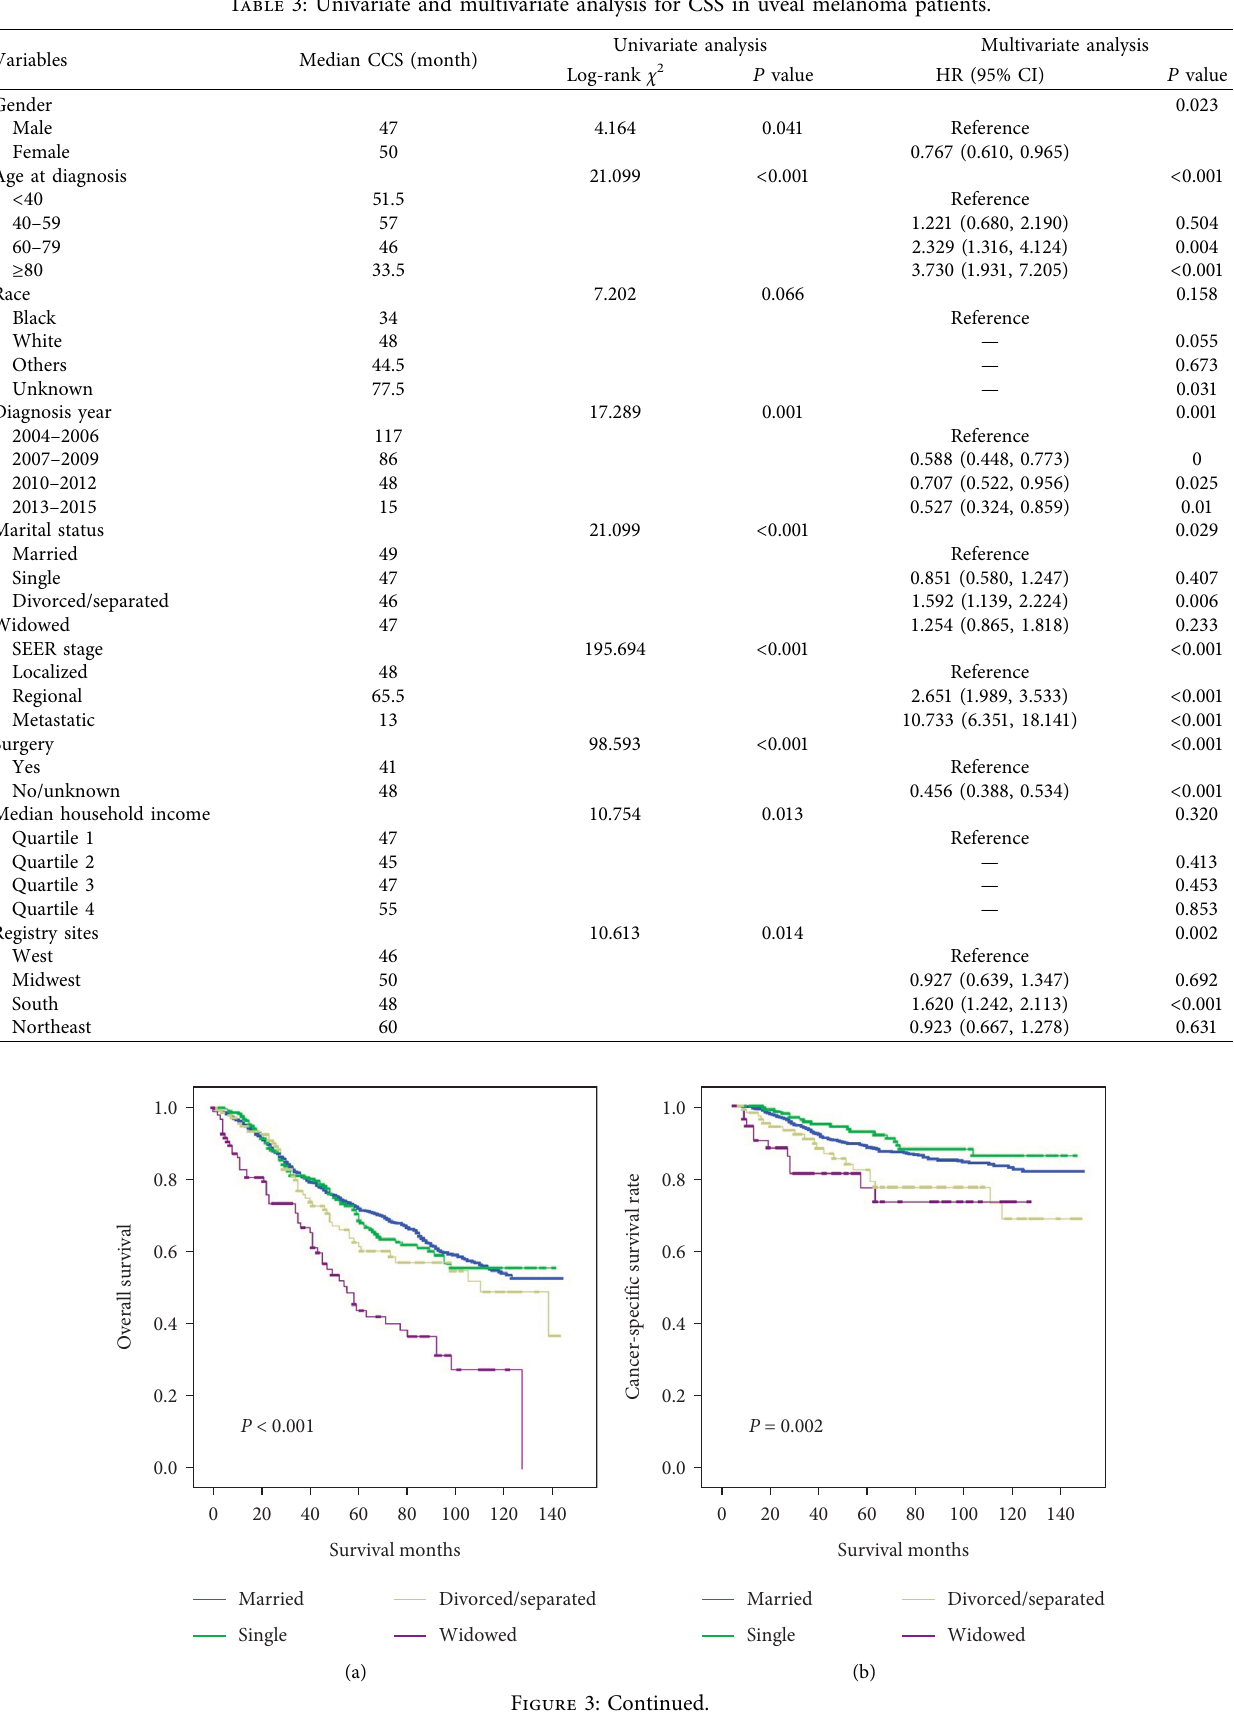
Table 3: Univariate and multivariate analysis for CSS in uveal melanoma